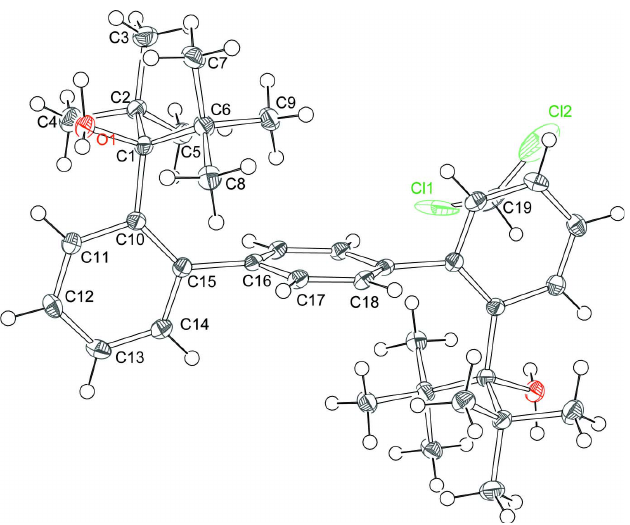
Figure 3 The structure of H 2 [OO] tBu (50% probability ellipsoids) is shown with the co-crystallized dichloromethane solvent molecule. The dichloromethane carbon atom was found to be disordered about an inversion center; only one orientation is shown, which is not the one belonging to the asymmetric unit. Hydroxyl H atoms are disordered over two positions, both positions are shown above.